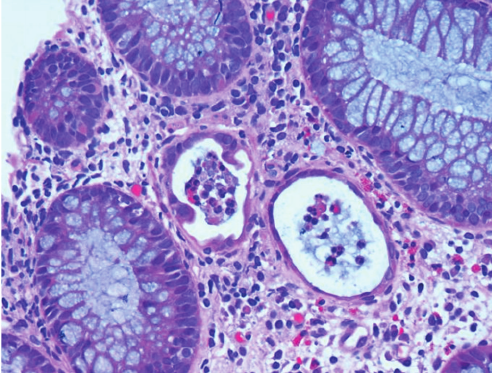
Figure 2: Colonic biopsy from solid organ transplant patient. Sec- tions of the mucosa show interspersed crypts with dilatation lined by flattened epithelium with inflammatory abscess. The cellularity of the surrounding lamina propria is increased (Hematoxylin and Eosin 40 ×